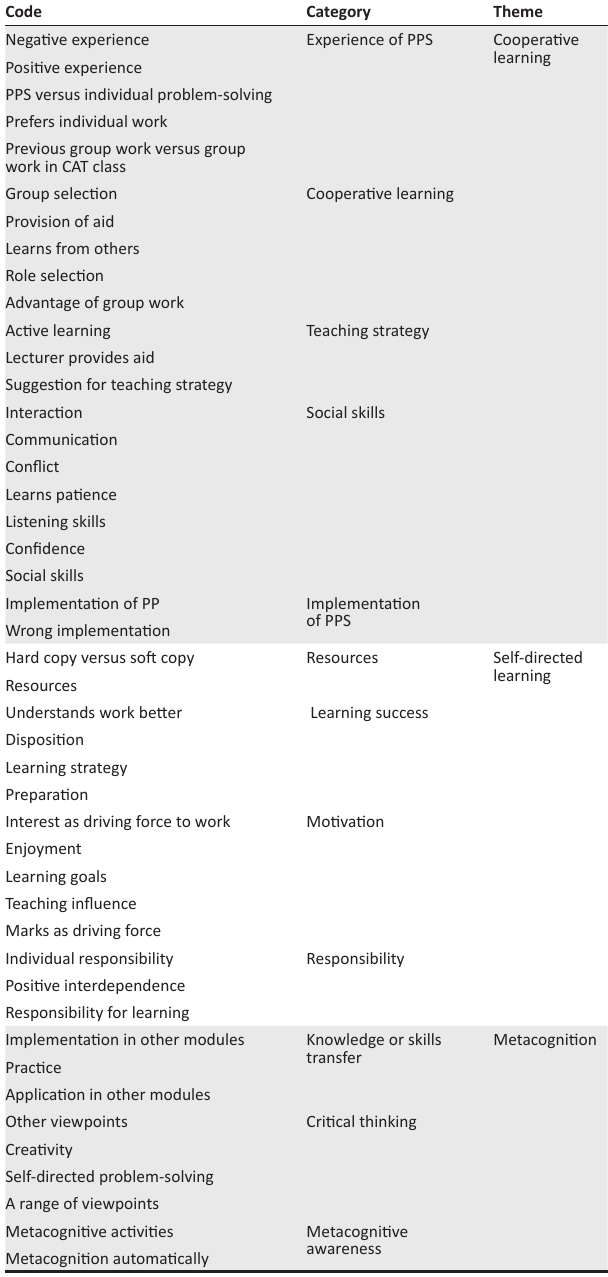
TABLE 5: Codes, categories and themes identified from students’ semi-structured